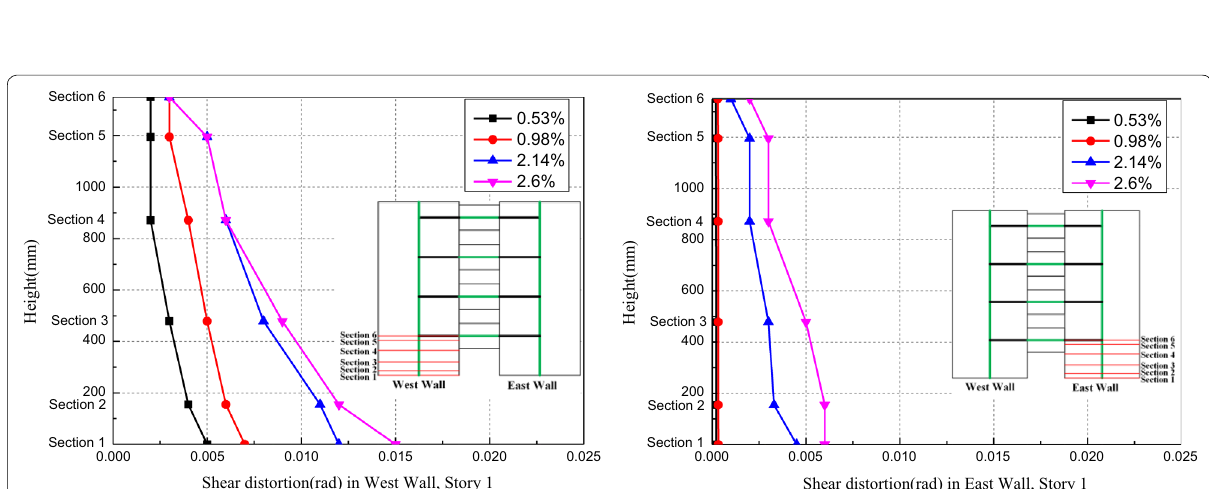
Fig. 20 Shear distortion of monitored sections (Gauss–Lobatto integration points) in positive drift direction of Specimen CW-1 (left wall, right tension =